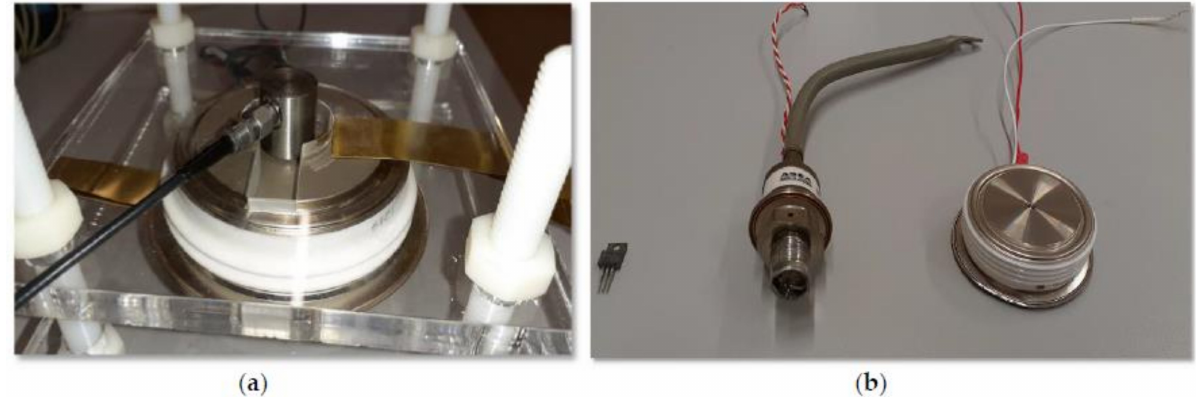
Figure 16. ( a ) The acoustic emission sensor and ( b ) the model of the thyristors in plastic ( left ), stud-mount ( middle ), and press-pack packaging ( right )